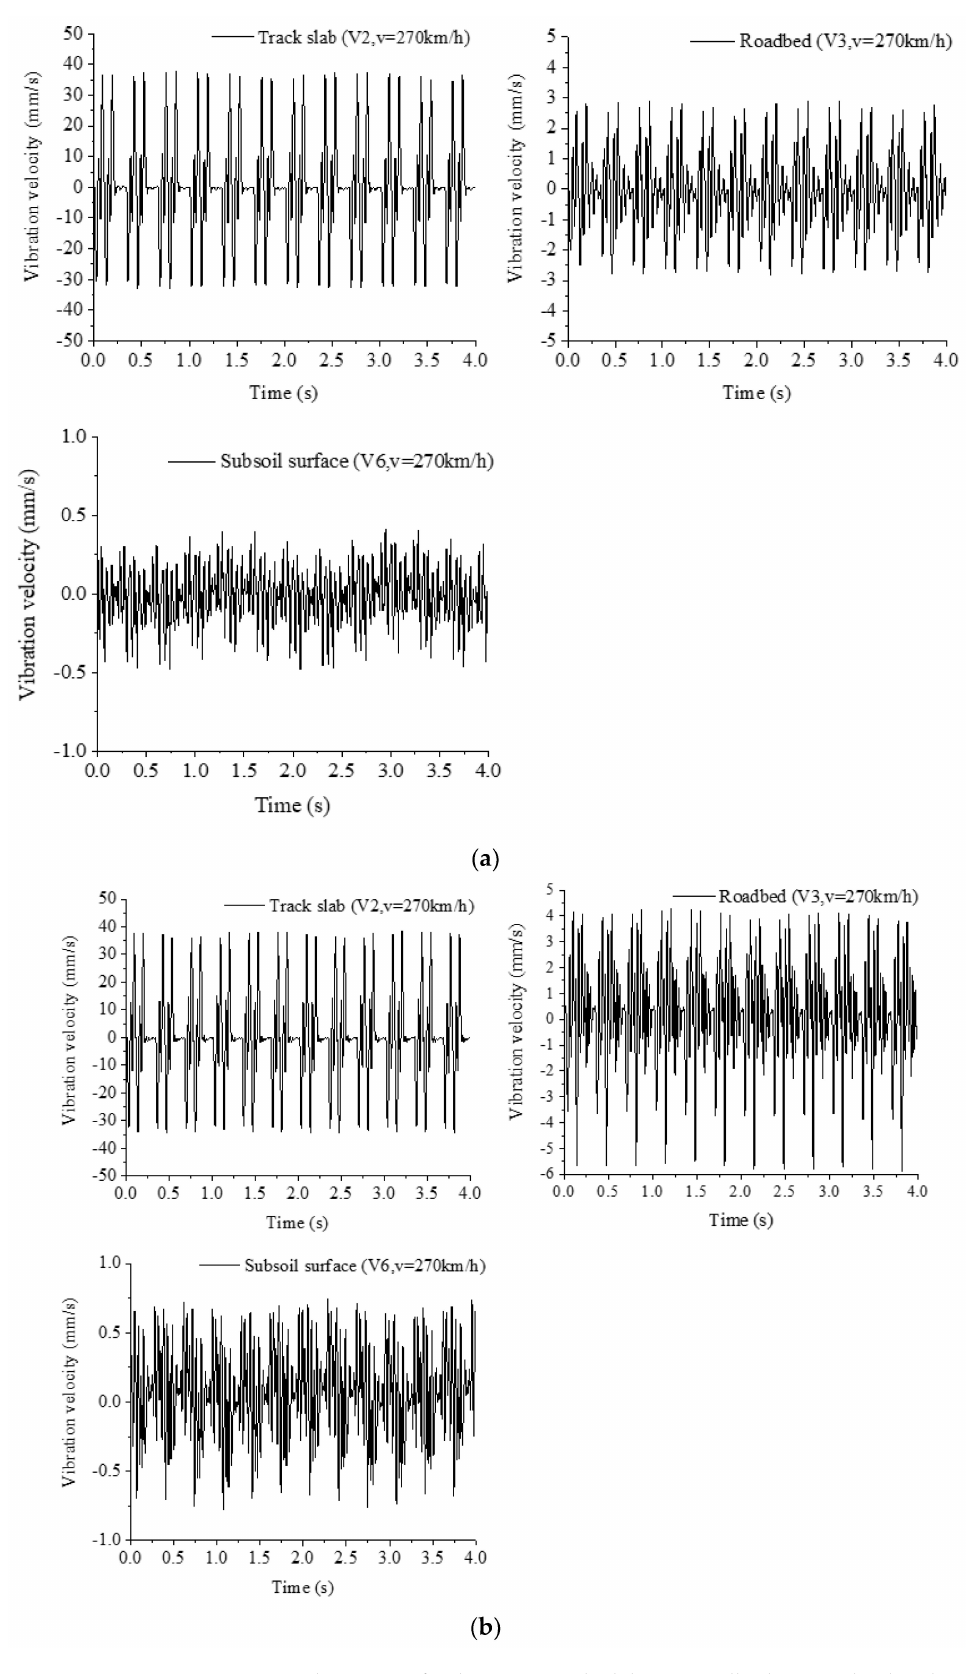
Figure 6. Time histories of velocity at track slab V2, roadbed V3, and subsoil surface V6. ( a ) Low water level, v = 270 km/h, ( b ) High water level, v = 270